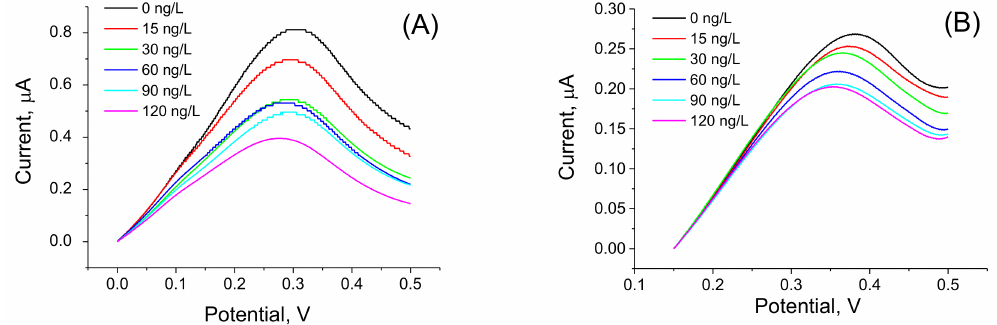
Figure 4. DPV of aptasensors based on biotinylated aptamers immobilized at Fc-modified neutravidin